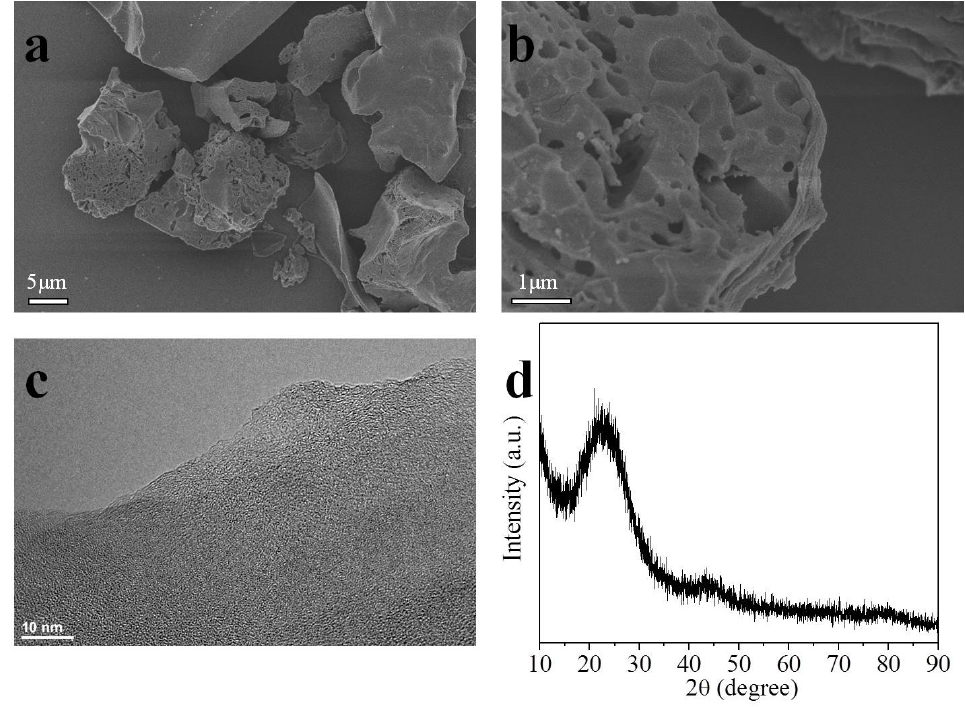
Figure 1. SEM images ( a , b ); TEM image ( c ); and XRD pattern ( d ) of